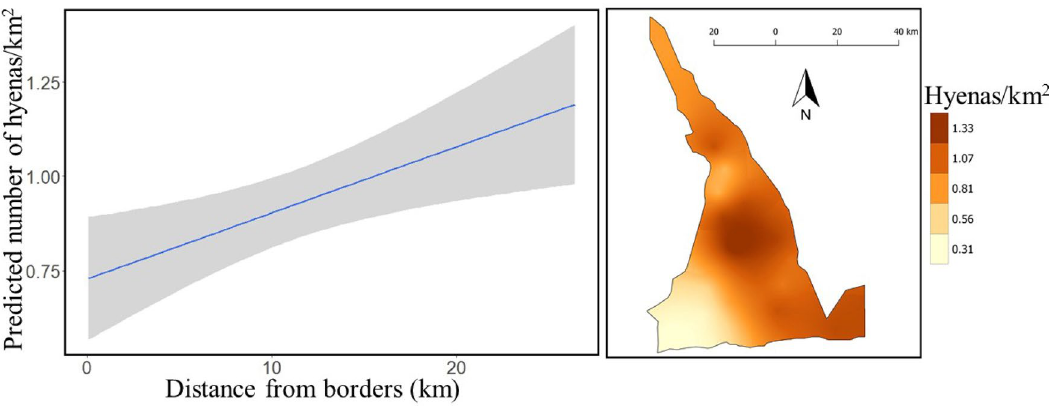
Figure 2. Estimated density of hyenas (left panel) in relation to distance from south and west borders and their spatial distribution (right panel), Maswa Game Reserve, Tanzania, 2017. Gray shading in left panel represents 95% credible